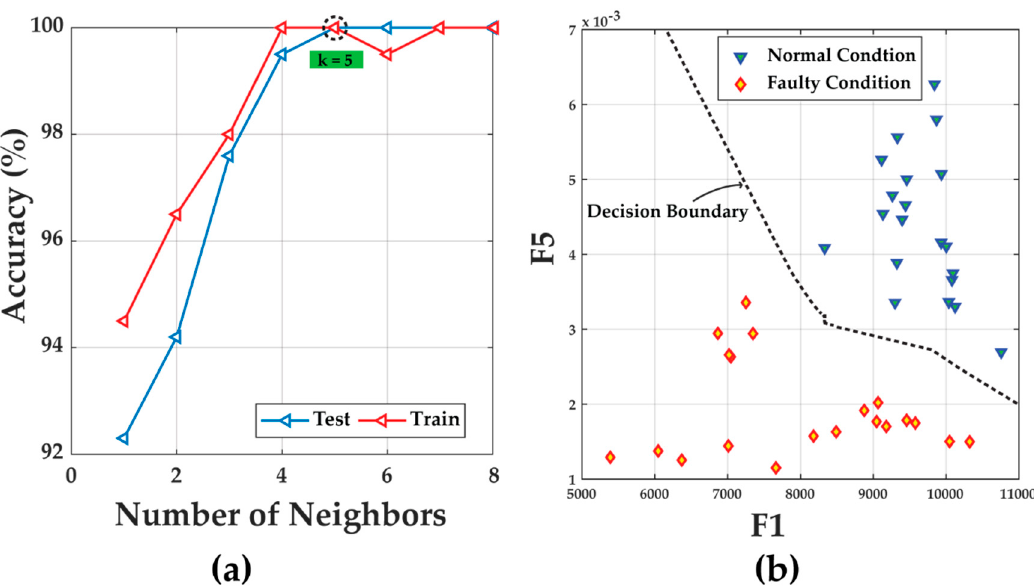
Figure 10. ( a ) Different classification accuracies as a function of the number of neighbors (k). The optimal value is k = 5. ( b ) Drawing of the decision boundary for separation of the two classes after determining the optimal value for k.